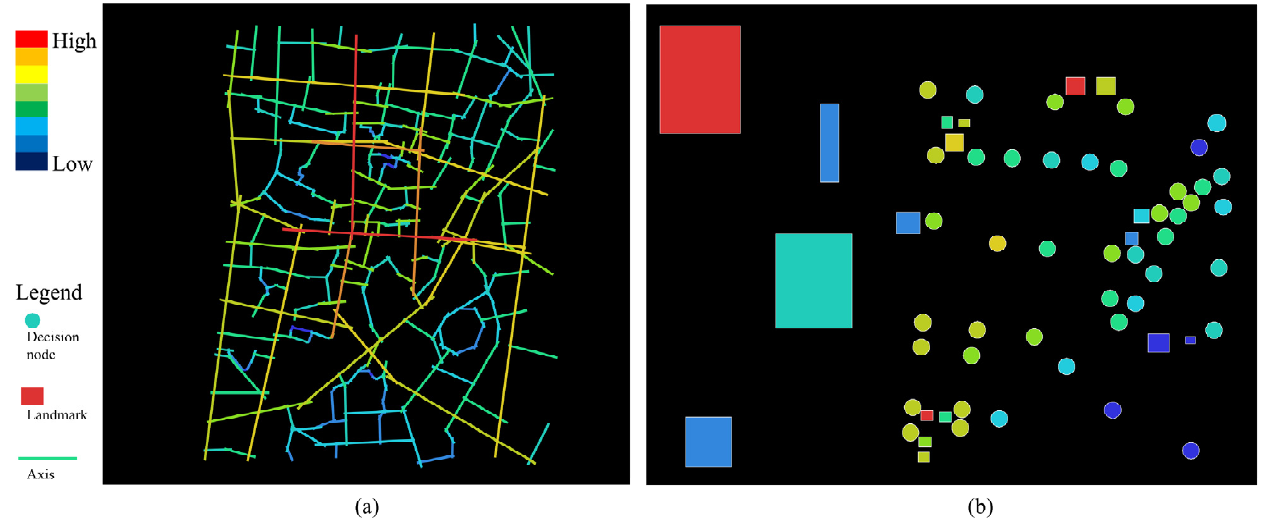
Figure 20. Comparing the calculation results of the node integration degree of the 3D NL GAM graph with the axial analysis graph in TP-District. ( a ) Axial analysis graph; ( b ) 3D NL GAM graph.